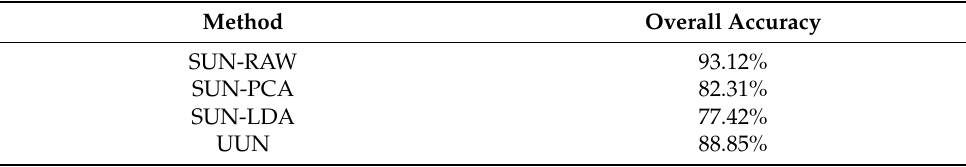
Table 8. Summary of Unknown mode ML-based approaches